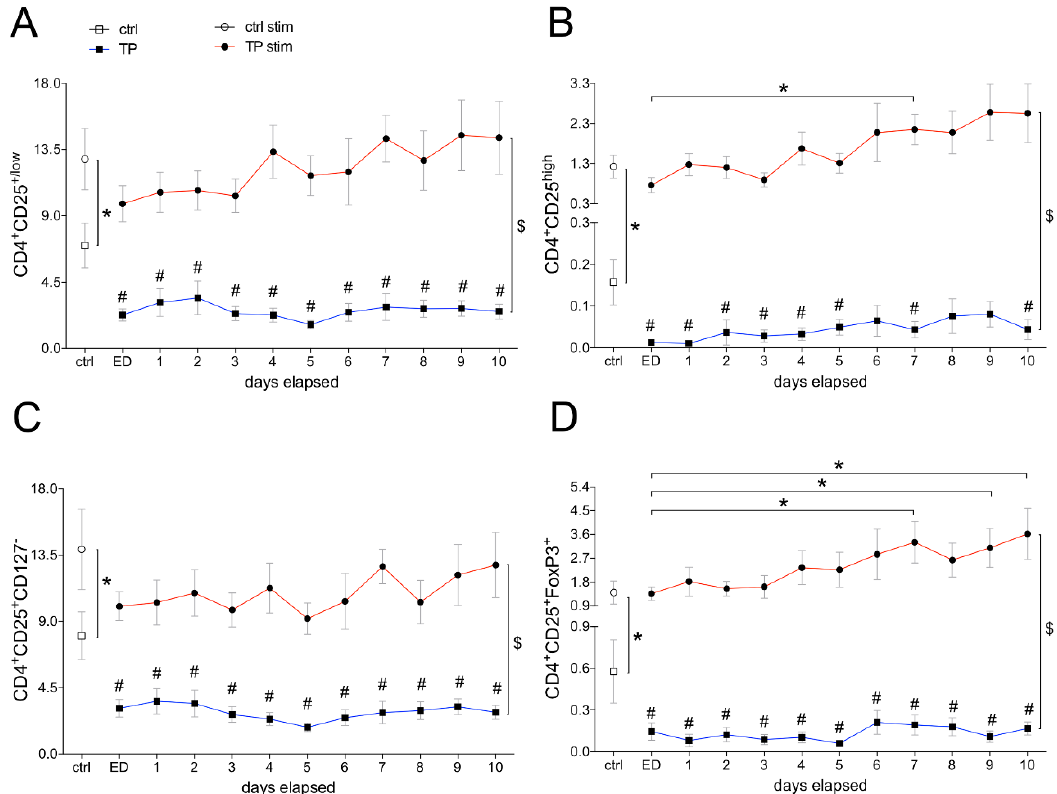
Figure 2. Whole blood from healthy volunteers (ctrl, n = 10, clear symbols) or major trauma patients (TP, n = 29, black symbols) was analyzed by flow cytometry over a 10-day time course after admission (emergency department, ED-10). Regulatory T cells (Tregs) were detected using anti-human CD4 and CD25 in the corresponding side and forward scatter. Unstimulated (square) and stimulated (circle, stim) cells were measured. Data are shown as mean ± SEM percentage of lymphocytes. ( A ): CD4 + CD25 +/low Tregs to CD4 + lymphocytes; ( B ): CD4 + CD25 +/high Tregs to CD4 + lymphocytes; ( C ): CD4 + CD25 + CD127 − Tregs to CD4 + lymphocytes; ( D ): CD4 + CD25 + FoxP3 + Tregs to CD4 + lymphocytes. p < 0.05 * vs. indicated #; unstimulated TP vs. unstimulated crtl $; stimulated TP vs. unstimulated TP.